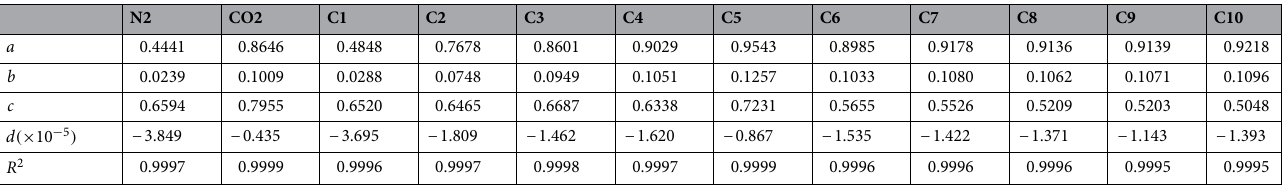
Table 2. Values of coefficients in the adsorption thickness equation (Eq.